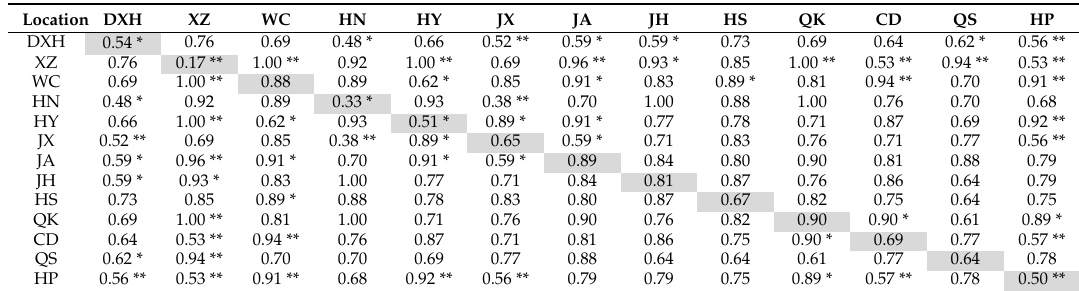
Table 4. Breakdown of crime exchange mobility,